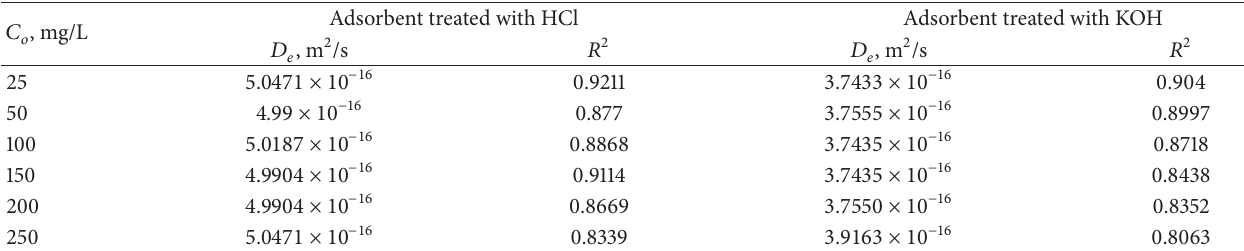
Table 7: The values of diffusion coefficients from the particle diffusion model at different concentrations. 𝐶 𝑜 ,